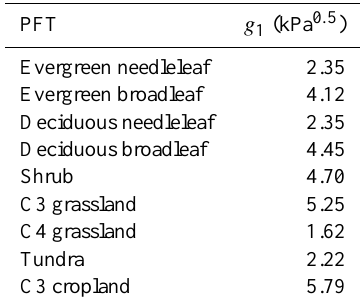
Table 1. Fitted g 1 values for the PFTs shown in Fig. 1.